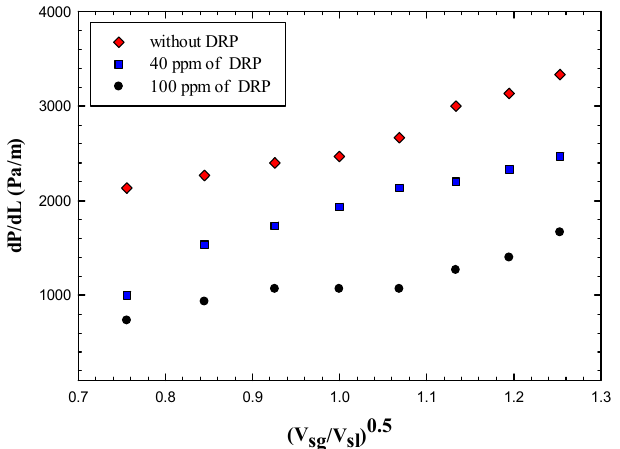
Figure 11. Effect of drag reducing polymer on slug flow regime using a concentration of 40 and 100 ppm.